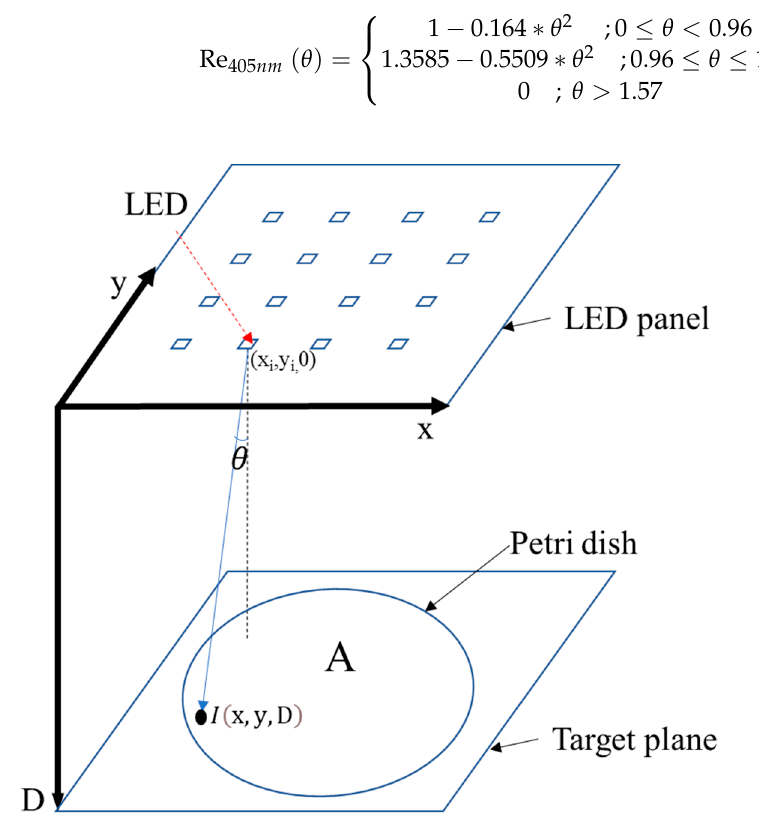
Figure 3. A schematic of the LED array and target plane for the radiation field model development.